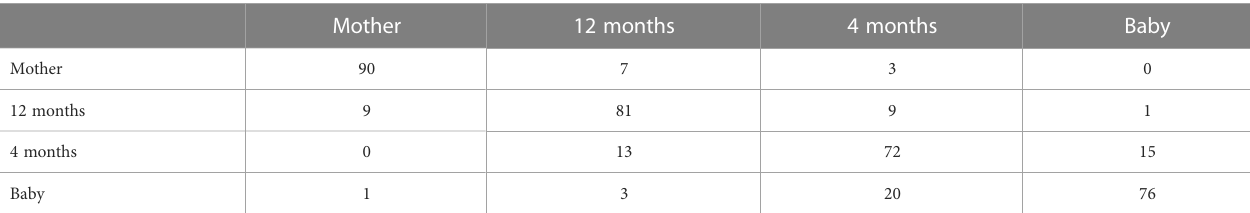
TABLE 4 Table of back discriminating results of 400